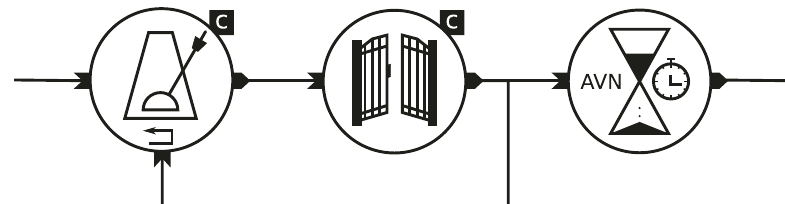
Fig. 5 Diagram of the modular conduction model with symbols for the components. Components from left to right: Pacemaker for the pacemaker effect of the AV node, RefractoryGate for the refractory behavior of the SA node and AVConductionDelay for the combined delay between the SA node and the ventricles. The C in a black box indicates that the main variable of the component is held constant while the stopwatch symbol for the delay should indicate that the duration is time-dependent. Components have their input on the left, their output on the right and the pacemaker has the additional reset input at the